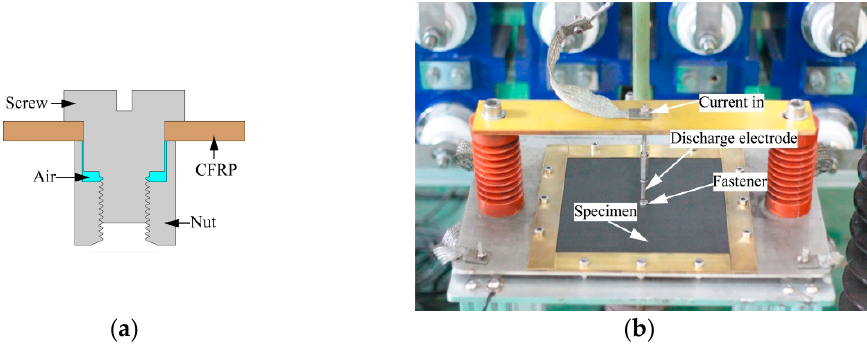
Figure 1. ( a ) Assembly diagram of the CFRP with a fastener; ( b ) the clamp and